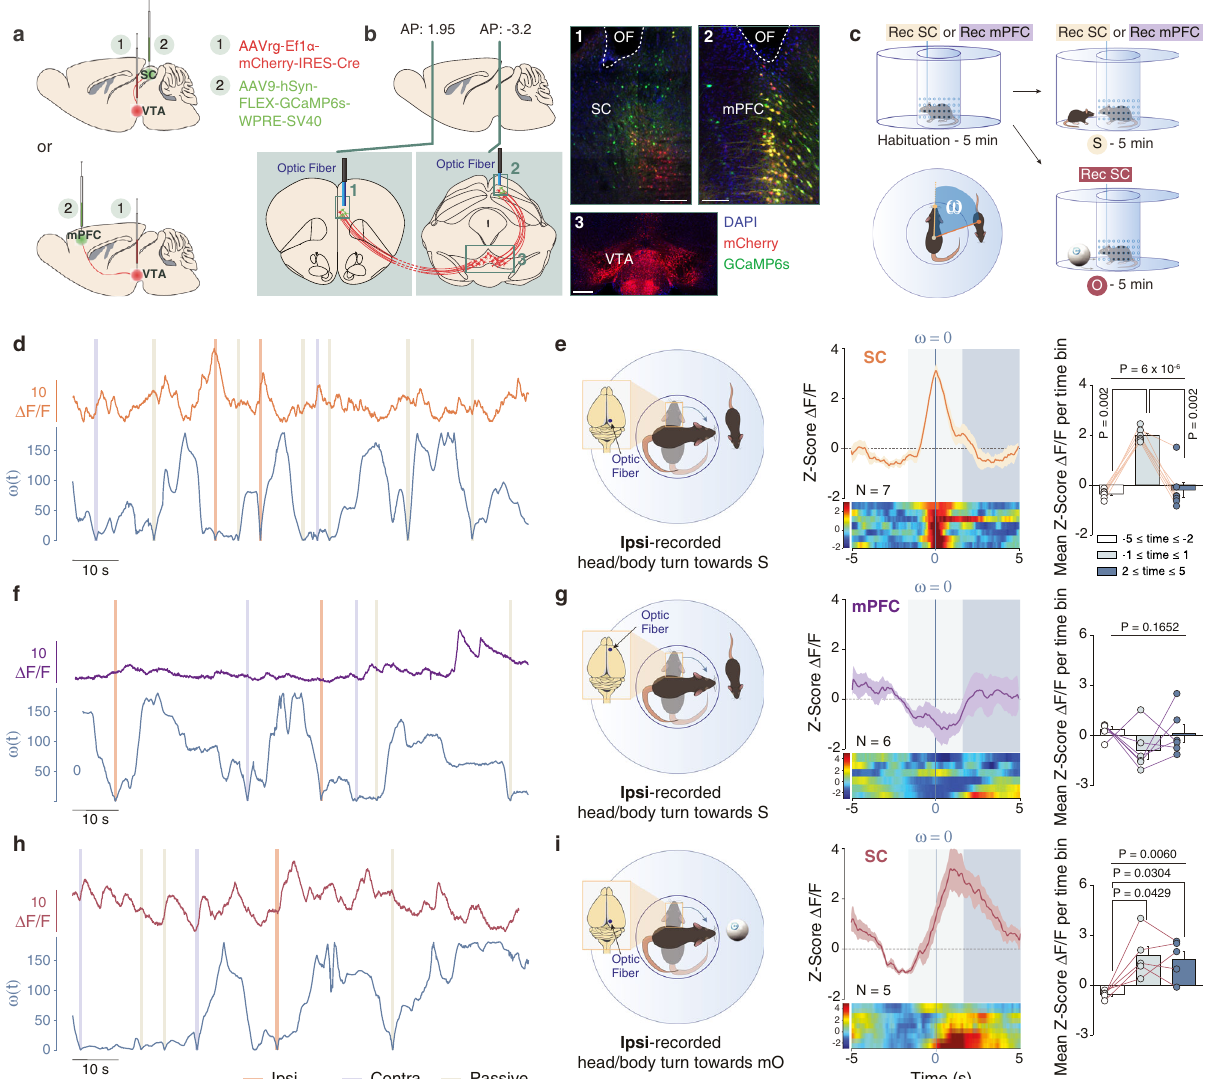
Fig. 2 Calcium activity of SC to VTA-projecting neurons during social and non-social orientation tests. a Schema of injections of AAVrg-Ef1 α -mCherry- IRES-Cre in the VTA and AAV9-hSyn-FLEX-GCaMP6s-WPRE-SV40 in the SC or mPFC. Representative coronal images of midbrain slices of adult mice infected with AAVrg-Ef1 α -mCherry-IRES-Cre in the VTA ( b panel 3, scale bar: 100 µ m) and AAV9-hSyn-FLEX-GCaMP6s-WPRE-SV40 in the SC ( b panel 1, scale bar: 50 µ m) and in the mPFC ( b panel 2, scale bar: 50 µ m). The location of the optic fi ber (OF) is indicated. Similar viral expression and OF location were observed in all the mice that performed the experiment described in Figs. 2c, 4b. c Schema of the social and non-social orientation test. Bottom left panel: Schema representing the points and vectors used for the calculation of the oriented angle towards the stimulus ( ω ). d , f , h Example traces. Δ F/F signals recorded in SC- or mPFC-VTA-projecting neurons aligned with instantaneous head orientation ω (t) during orientation test. Ipsi-recorded and contra-recorded head/body turn episodes are reported as well as the passive crossing events. e Left panel: Schema of the ipsi-recorded head/body turns towards the social stimulus (S). Middle panel: Peri-event time histogram (PETH) of normalized Δ F/F for SC-VTA-projecting neurons, centered on ipsi- recorded orientation towards social stimulus. Right panel: Mean Δ F/F (Z-score) before, during and after ipsi-recorded orientation. Repeated measures (RM) one-way ANOVA (Events main effect: F (2,6) = 44.34, P < 0.0001) followed by Bonferroni-Holm post-hoc test correction. g Left panel: Schema of the ipsi-recorded head/body turns towards the social stimulus (S). Middle panel: PETH of normalized Δ F/F for mPFC-VTA-projecting neurons, centered on ipsi-recorded orientation towards social stimulus. Right panel: Mean Δ F/F (Z-score) before, during and after ipsi-recorded orientation. RM one-way ANOVA (Events main effect: F (2,5) = 2.17, P = 0.1652). i Left panel: Schema of the ipsi-recorded head/body turns towards the moving object (mO). Middle panel: PETH of normalized Δ F/F for SC-VTA-projecting neurons, centered on ipsi-recorded orientation towards moving object. Right panel: Mean Δ F/F (Z- score) before, during and after ipsi-recorded orientation. RM one-way ANOVA (Events main effect: F (2,4) = 10.34, P = 0.0060) followed by Bonferroni- Holm post-hoc test correction. N indicates the number of mice. All the data are shown as the mean ± s.e.m. as error bars or error bands. Source data are provided as a Source Data fi